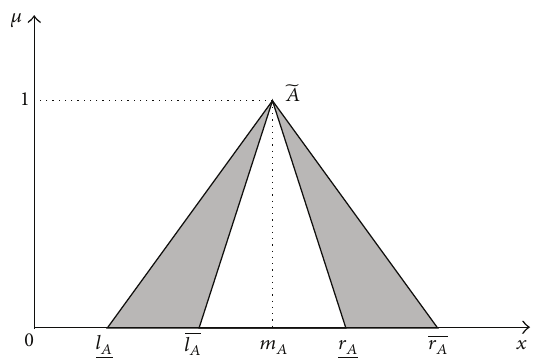
Figure 1: A triangular interval type-2 fuzzy